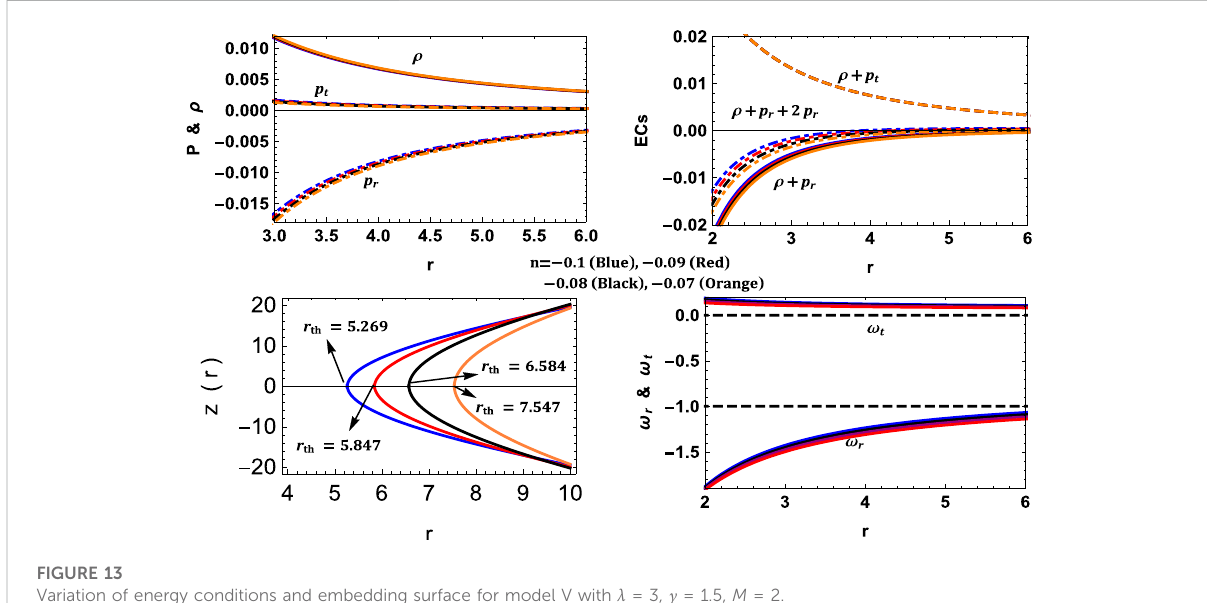
FIGURE 13 Variation of energy conditions and embedding surface for model V with λ = 3, γ = 1.5, M = 2.